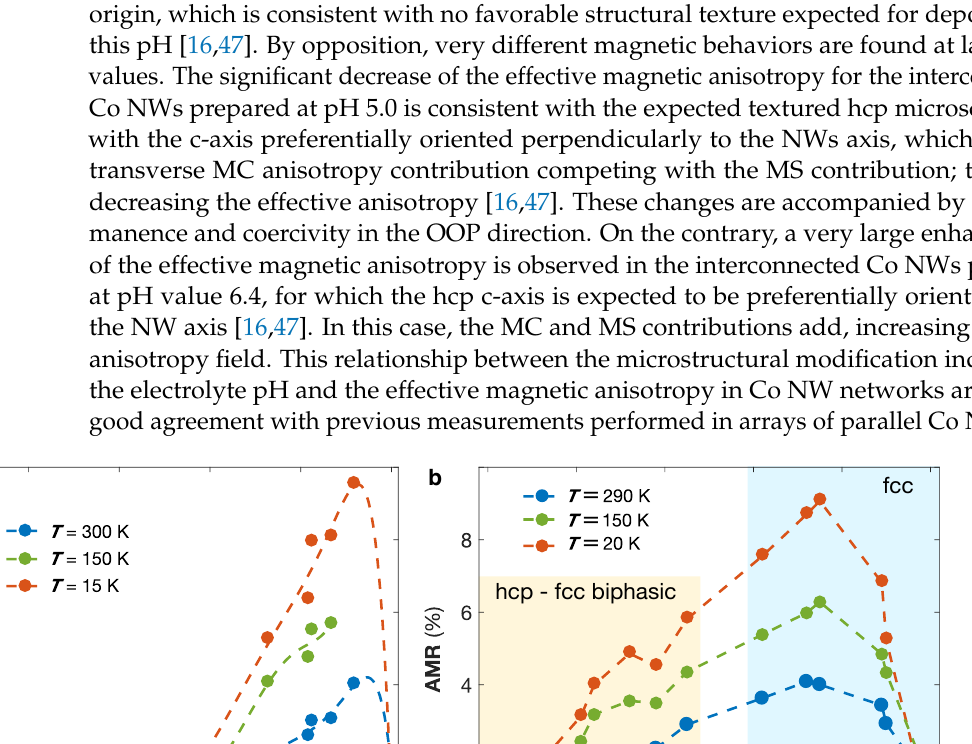
Figure 4. ( a ) Anisotropic magnetoresistance (AMR) ratio as a function of the Ni content x at T = 300 K, 150 K, and 15 K for the Ni x Fe 1 − x , with 0.5 ≤ x ≤ 1, and Fe nanowire networks with 80 nm in diameter and 3% in packing fraction. The dashed lines are guides for the eyes provided by polynomial approximation of the data. ( b ) AMR ratio as a function of the Ni content x at T = 290 K, 150 K, and 20 K for the Ni x Co 1 − x , with 0 ≤ x ≤ 1 networks with 40 nm in diameter and 20% in packing fraction. The dashed lines are guides for the eyes. The hcp-fcc biphasic and fcc microstructures of the NiCo alloy nanowires are indicated by the yellow and light blue areas,